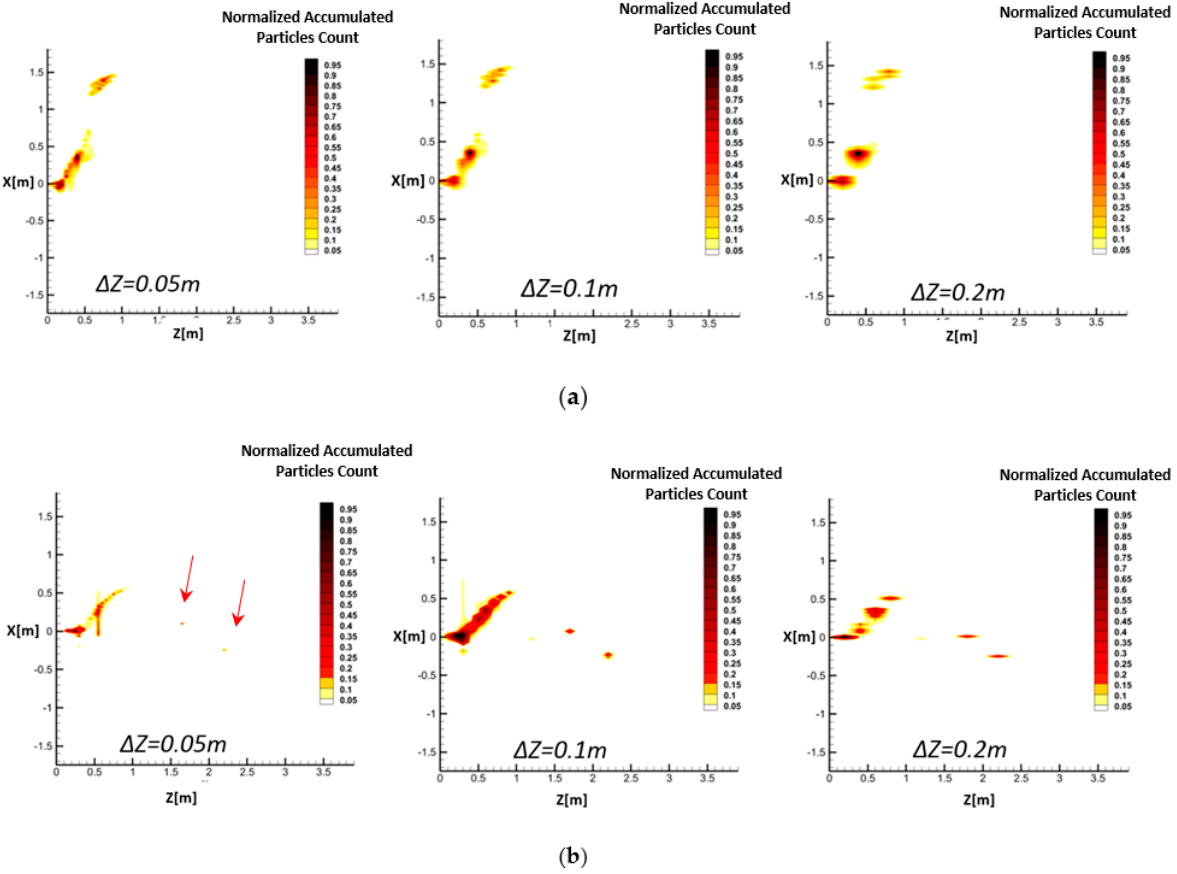
Figure A2. The impact of ∆ Z size on the distribution of the accumulated number of droplets in ( a ) a cough with velocity = 8 m.s − 1 , temperature = 15 °C, and RH = 50%, and ( b ) a sneeze with velocity = 50 m.s − 1 , temperature = 29 °C, and RH = 50%.